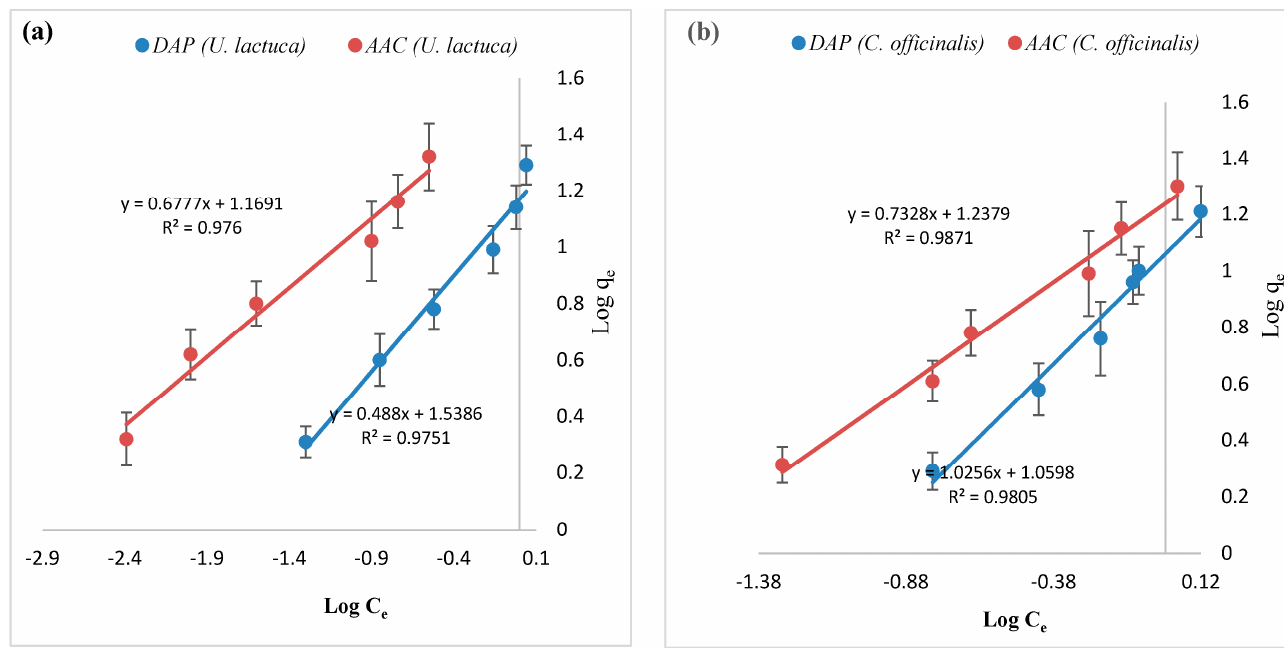
Figure 9. ( a , b ). Freundlich’s adsorption isotherm for Zn +2 on DAP and AAC of ( a ) Ulva lactuca ( b ) Corallina officinalis . Each data point represents the mean ± SD.